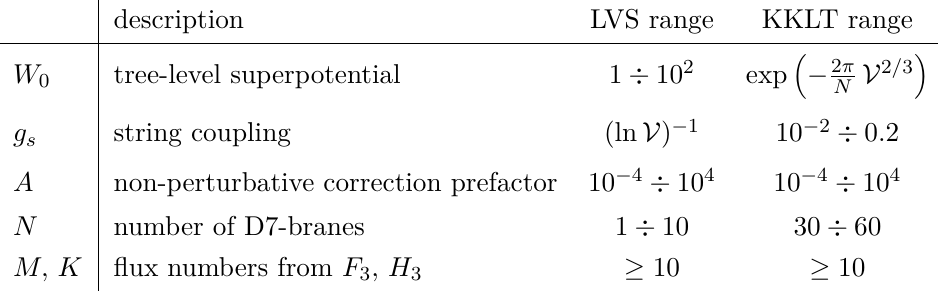
cannot be interpreted 0